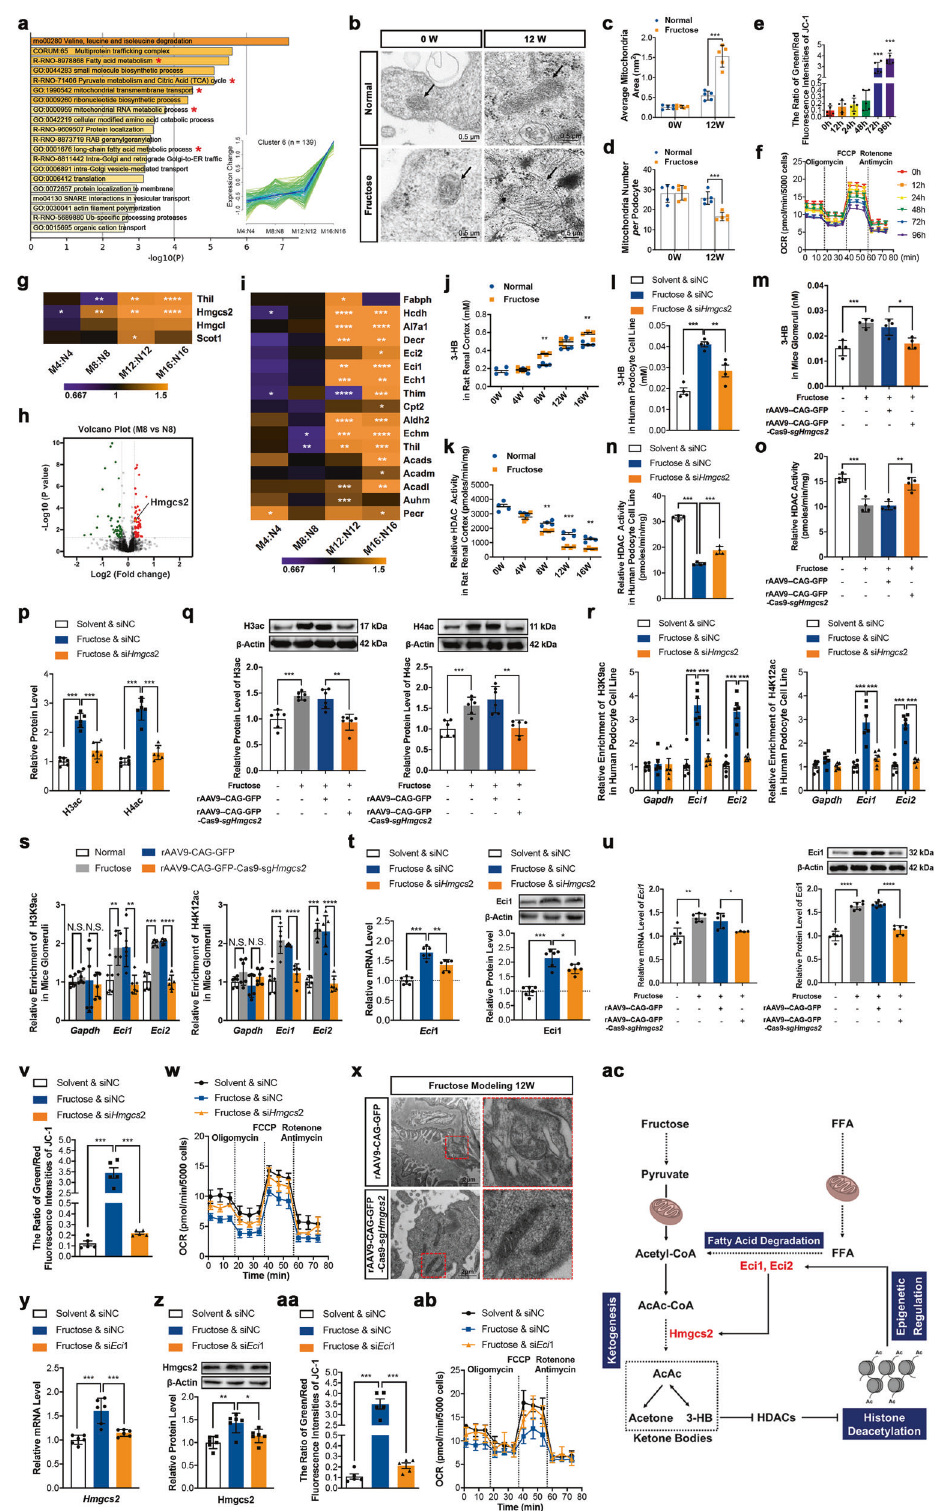
respiration induced by high fructose in differentiated podocytes (Fig. 1ab and Supplementary Fig. S10b – d, i – l). Thus, our study reveals an epigenetic modi fi cation mediated-positive feedback mechanism containing ketogenesis and fatty acid degradation to regulate mitochondrial metabolic reprogramming during high fructose-induced podocyte injury (Fig.